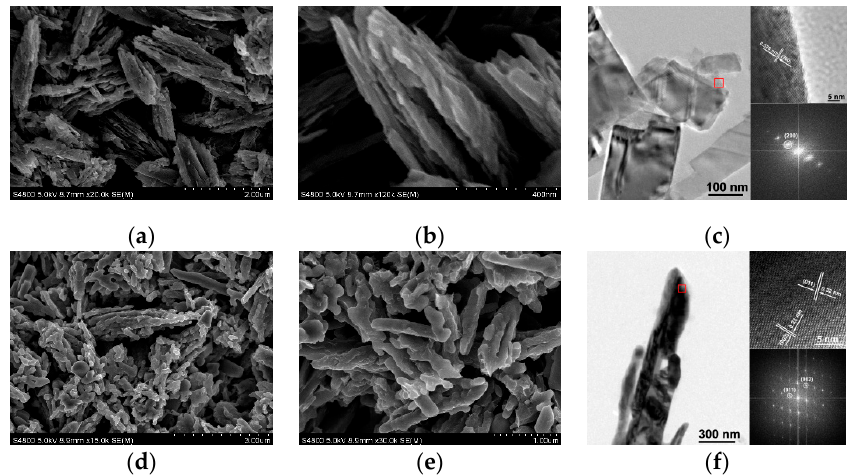
Figure 3. ( a ) Low- and, ( b ) high-magnification SEM images of V 2 O 5 specimen obtained after annealing